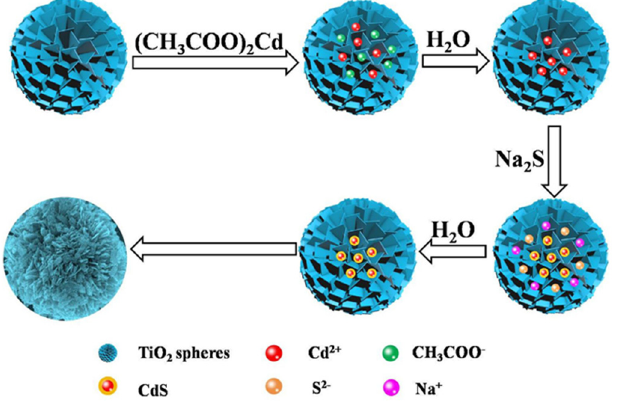
Figure 16. Schematic illustration for the fabrication of TiO 2 /CdS photocatalyst. Copyrights 2017 Elsevier [144].